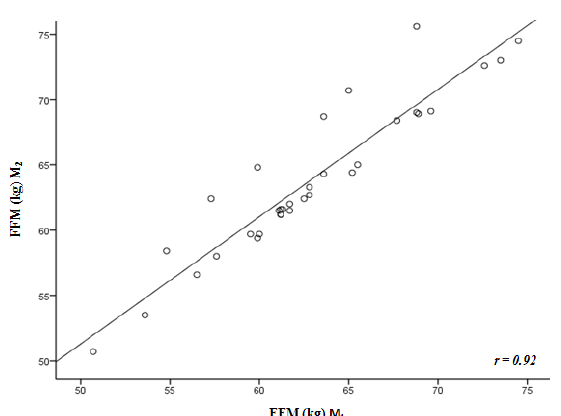
Figure 9 Correlation between the values of param- eters measured by Nutriguard-M before and after the intake of fluids – fat free mass (kg)